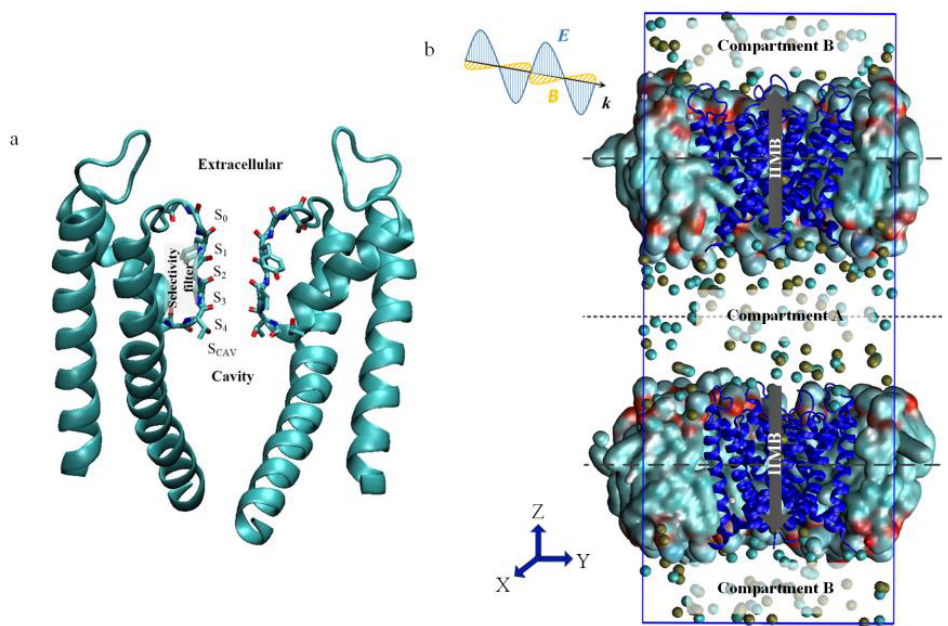
Figure 1. ( a ) Open and conductive state of KcsA with the main K + binding sites of the SF between the four channel subunits. ( b ) The CEF-IIMB combined model. The simulation system consists of two membranes, each including open KcsA, surrounded by water and ions (the yellow balls are K + , and the blue balls are Cl − ). The transmembrane potential is generated by sustaining a small charge imbalance ∆ q between compartments A and B by the IIMB method. The CEF method is used to simulate the external THz-EM field.